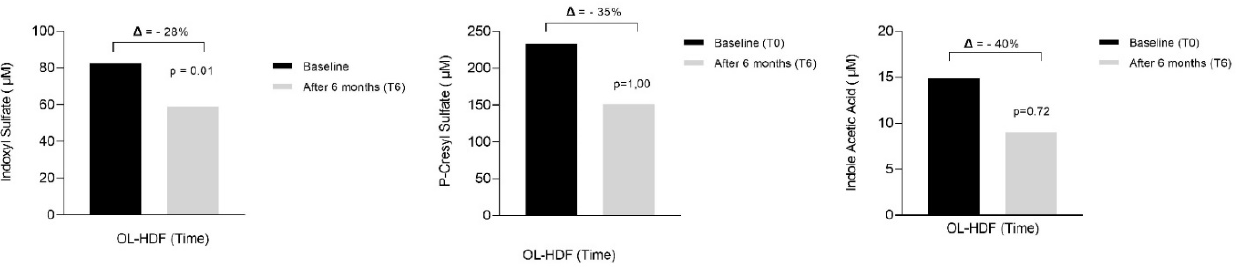
Figure 2. Correlation between Indoxyl sulfate (IS) and intact parathyroid hormone (iPTH), phos- phate and 25 vitamin D. A sub analysis revealed a reduction in alkaline phosphatase (from 103 ± 39 to 86 ± 25, p = 0.04) and CRP [from 5.30 (1.23–26.0) to 2.44 (1.59–11.1), p = 0.04] in patients who exhib- ited a reduction in IS and IAA, respectively (Figures 3 and 4). Figure 3. Alkaline phosphatase serum concentration in patients who showed a reduction in the se- rum concentration of Indoxyl Sulfate over 6 months of online hemodiafiltration (OL-HDF).